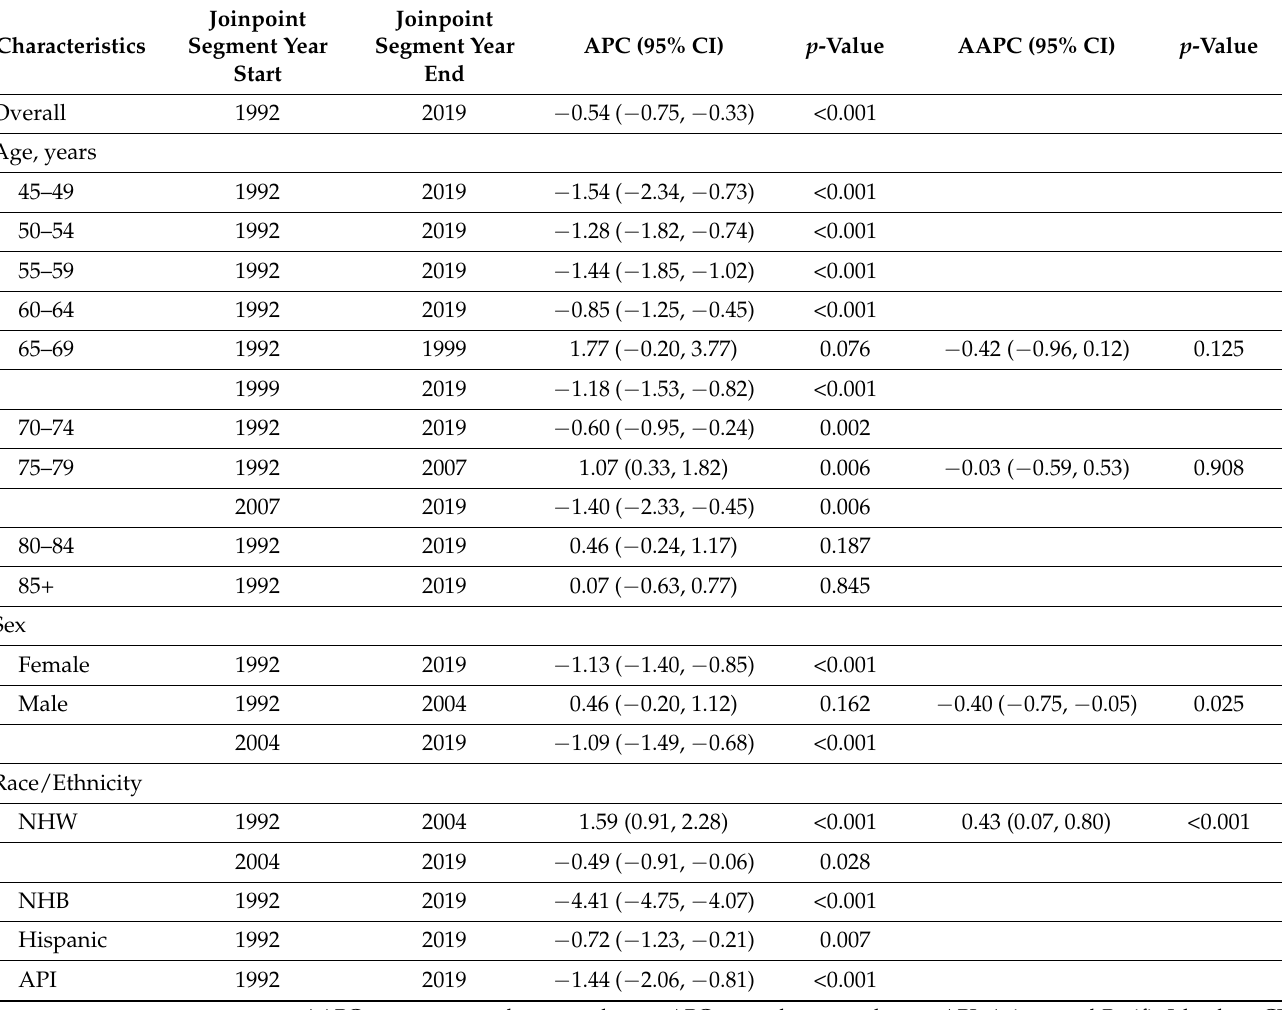
Table 1. Annual percent change (APC) and average annual percent change (AAPC) in EC rates over time, overall, and by age group, sex, and race/ethnicity.